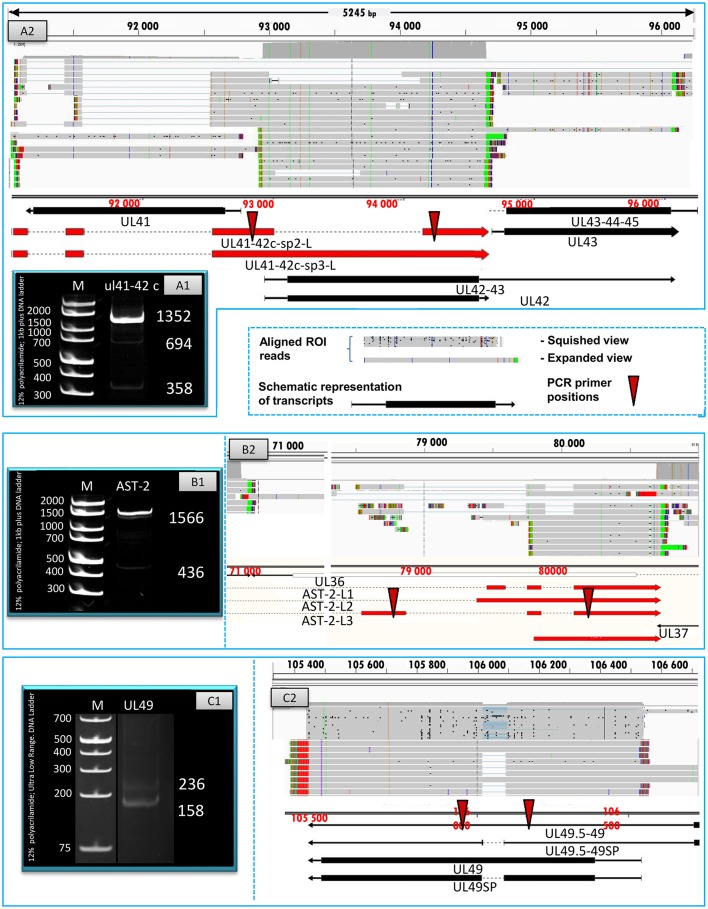
Splice isoforms. PCR validation of the splice sites of the UL41-42 complex transcript (A1), AST-2 transcript (B1), and the UL49 RNA (C1). (A2) Shows the coverage of reads across the examined genomic region, the ROIs (gray rectangles) and the schematic representation of the genes (red or black arrows). (B2) Illustrates the expanded view of ROIs, the read coverage along analyzed region and the schematic view of AST-2 and adjacent genes. (C2) Graph shows the read coverage, the ROIs and the schematic representation of the examined region. The numbers on the left side of panels A1, B1, and C1 indicate the sizes of DNA ladders while the numbers on the right side of these panels indicate the sizes of the PCR products amplified from the splice junction regions of the various splice isoforms (see Table 5). (A1) The 1,358-bp band shows the unspliced, while the 694- and the 388-bp bands show the two splice variants of the UL41-42 transcripts. (B1) The 1,566-bp indicates the unspliced, while the 436-bp band show the spliced version of AST-2 transcript. (C1) The 236-bp band shows the unspliced, while the 158-bp band shows the spliced isoform of UL49 mRNA. The colors indicate the poly(A) tails of the transcripts; green: from left to right orientation, red: from right to left orientation. The striped colors indicate the Clontech adaptor (universal primer binding site) used for the PCR amplification. They are labeled as such because they do not map to the PRV genome. The vertical red arrows indicate the precise location of the forward and reverse PCR primers on the HSV genome.